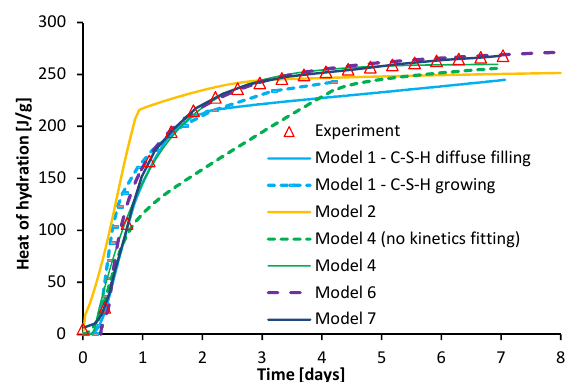
Figure 2. Comparison of the experimental isothermal calorimetry data (average from two replicate samples (difference in cumulative heat of 1% at most) and simulation results for different models.